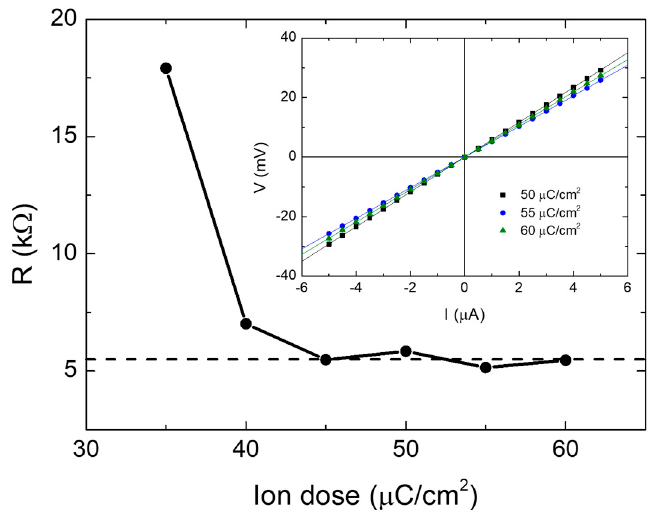
Figure 6. Electrical resistance as a function of the Ga + irradiation dose in W-C deposits grown by Cryo-FIBID, suggesting that an optimized dose to achieve the lowest resistance value occurs in the 45 to 60 μ C/cm 2 range. The current-versus-voltage measurements shown in the inset are compatible with metallic behavior. Adapted and reprinted from Córdoba et al., Scientific Reports 2019 [55].